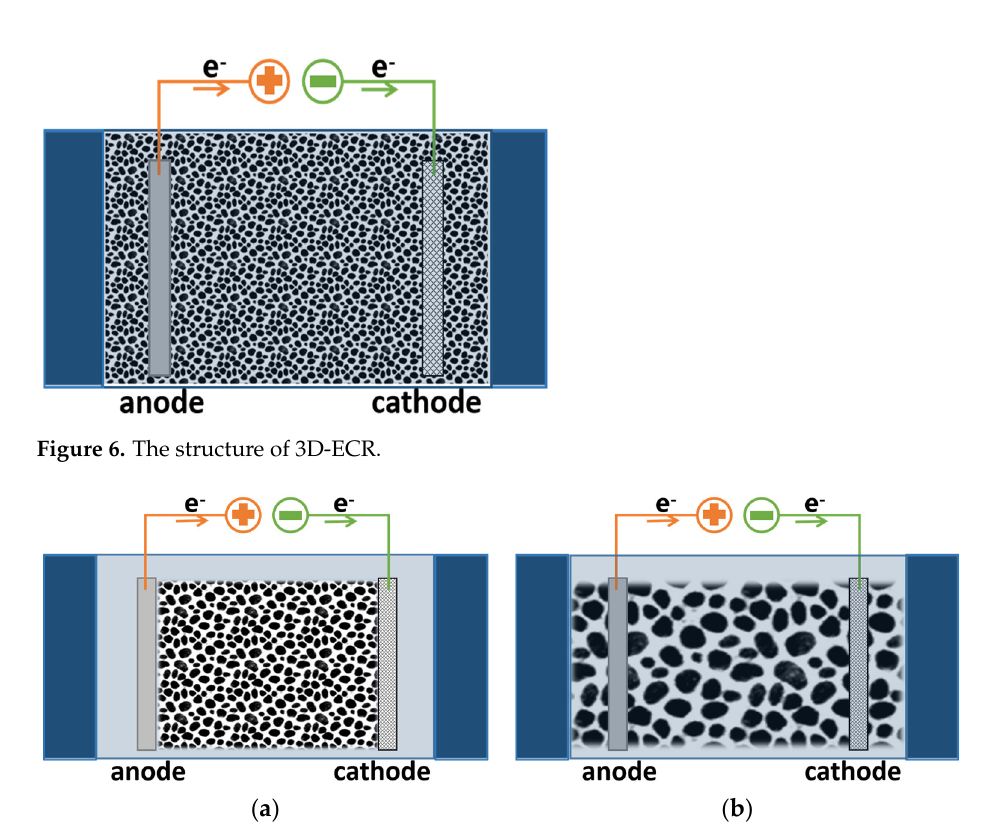
Figure 7. 3D fixed bed mode ECR ( a ) and 3D fluidized bed mode ECR ( b ).